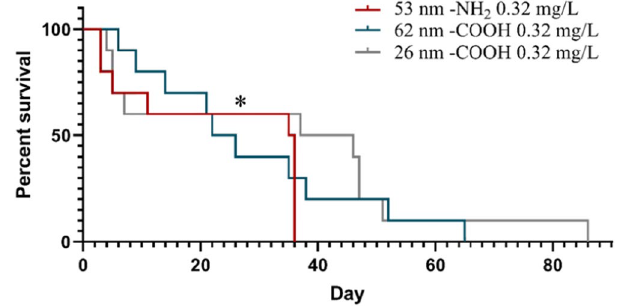
Figure 4. Comparison of Daphnia magna survival during life-time exposure to 53 nm PS-NH 2 , 62 nm PS- COOH and 26 nm PS-COOH at 0.32 mg/L. Asterisk indicates significant difference compared to the control group throughout the study period, * p <